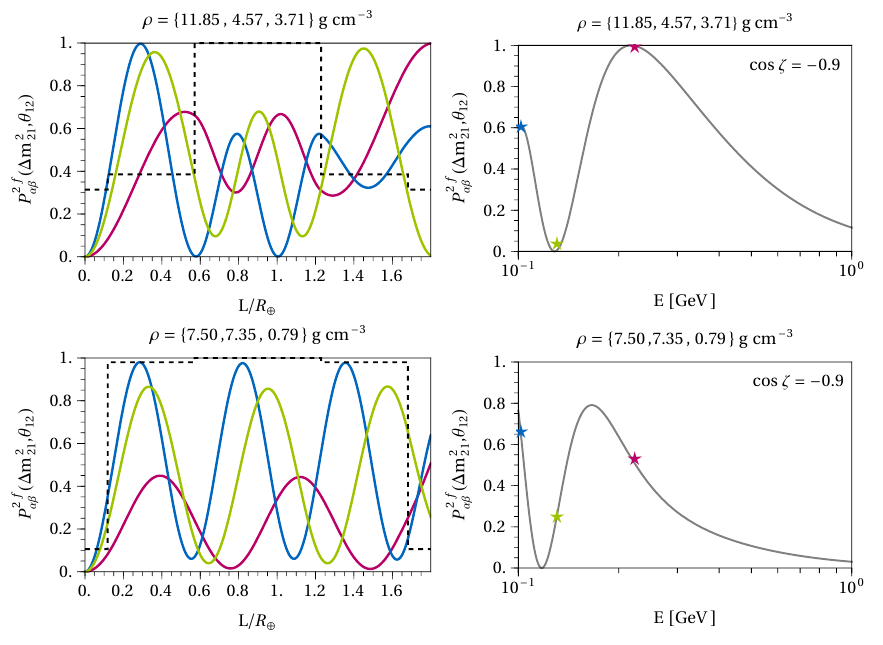
as function of the travelled distance inside Figure 5 . Two-flavor oscillation probability P 2f αβ the Earth (left) and energies (right) assuming the true density values of the layers, ρ = { 11 . 85 , 4 . 56 , 3 . 72 } g cm − 3 (top), and values that produce the same Earth mass and moment of inertia ρ = { 7 . 50 , 7 . 35 , 0 . 79 } g cm − 3 (bottom). The oscillation parameters here correspond to the solar values ∆ m 2 , θ 12 . The red, blue and green lines in the left panels correspond to the stars on 21 the right, and are extrema of the oscillation probability in the true